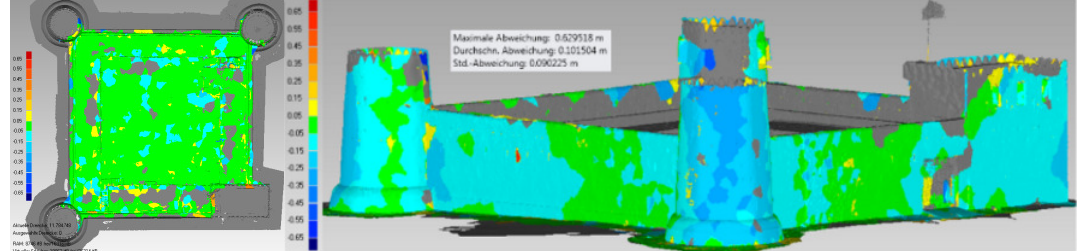
Figure 12: Bundler/PMVS2 & VisualSFM vs. reference – deviations of the 3D point cloud (left, green = ±5cm) and the meshed 3D model (right, green = ±10cm)